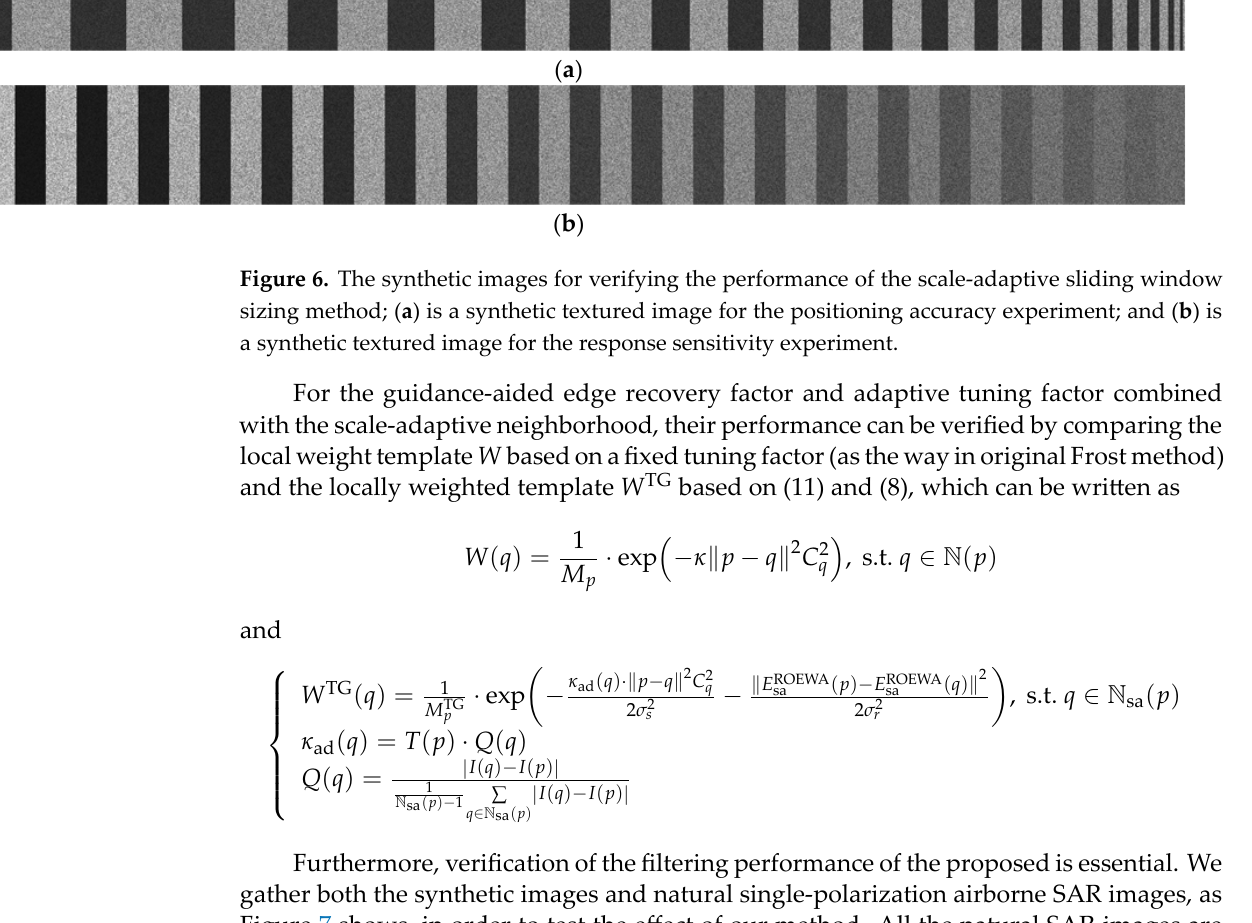
Table 1. Sizes and parameter sets of the proposed method for images. Image